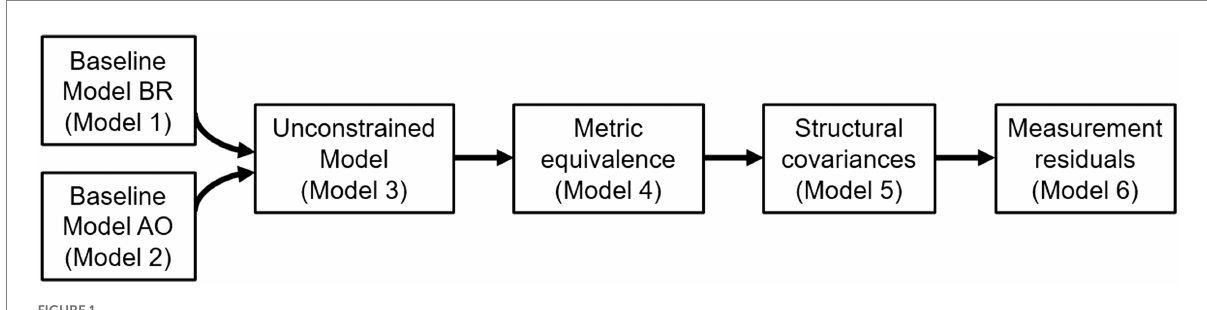
FIGURE 1 Flow diagram of the cross-cultural validity and measurement